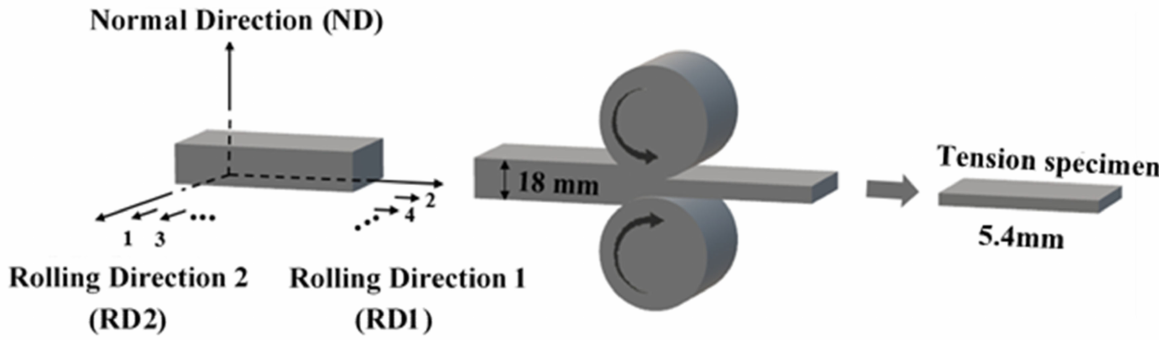
Figure 1. The schematic diagrams of hot